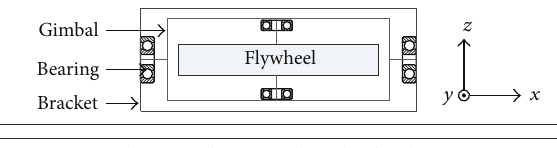
8: CMG- fl exible interface coupling system.